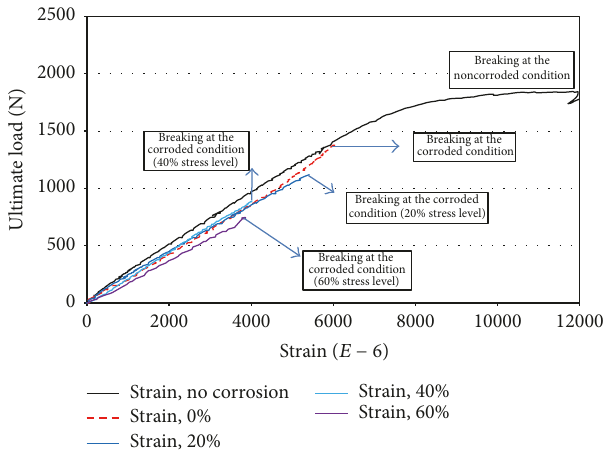
Figure 8: Stress-strain curve in corroded tendon after ICM test.